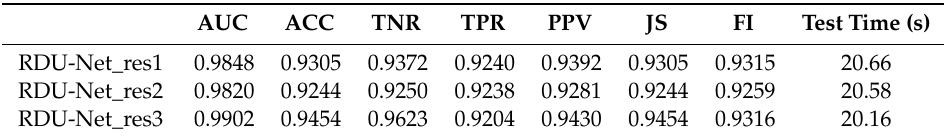
Table 2. Performance of the three models